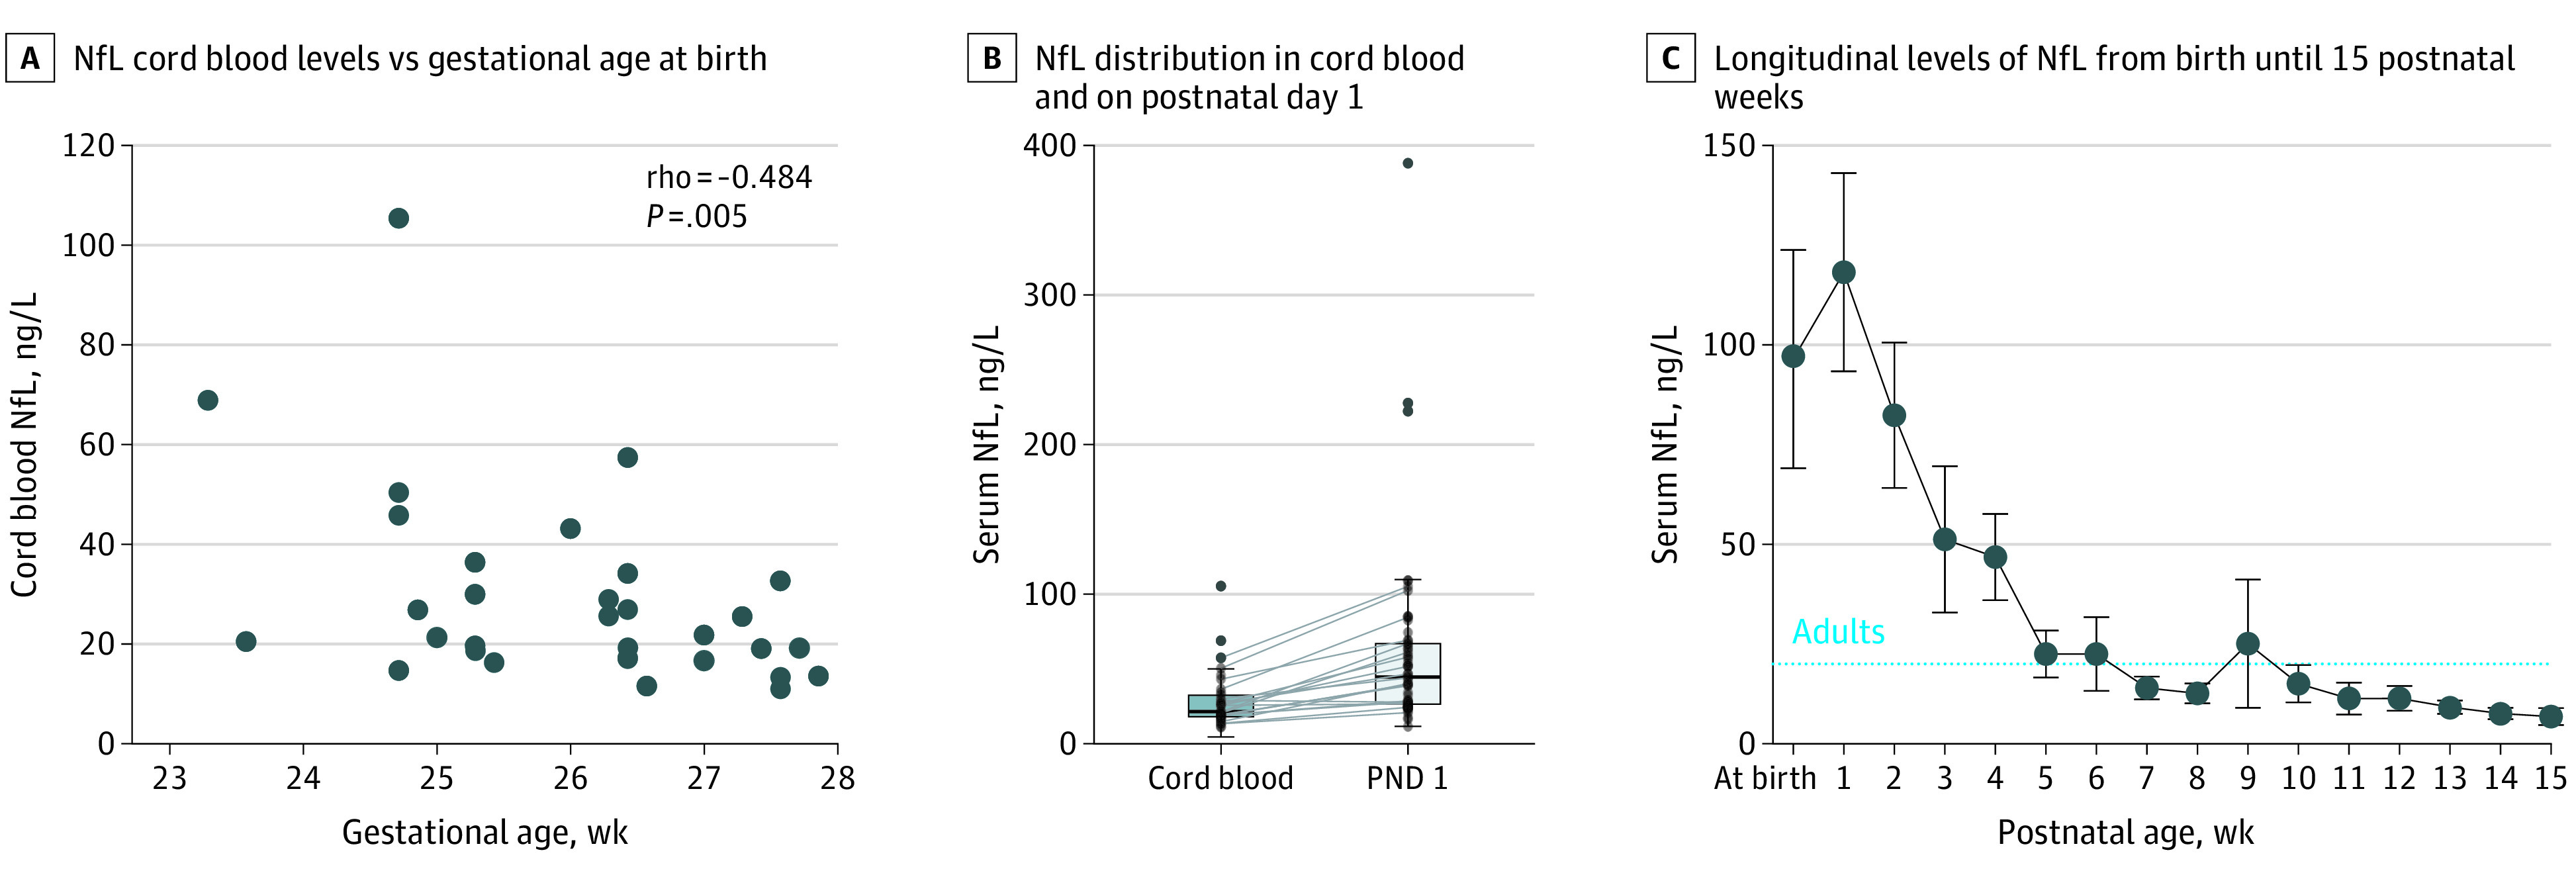
Neurofilament Light (NfL) LevelsB, NfL levels significantly increased between cord blood and PND 1 samples (Wilcoxon signed-rank test, P < .001). Levels for 23 infants who had repeated samples are connected with lines. C, NfL was measured in 120, 128, 121, 82, 115, 98, 85, 85, 77, 77, 60, 54, 43, 43, 20, and 11 infants at birth and weeks 1-15, respectively. The dotted horizontal line represents mean levels in healthy adults.38 Error bars represent 95% confidence intervals.